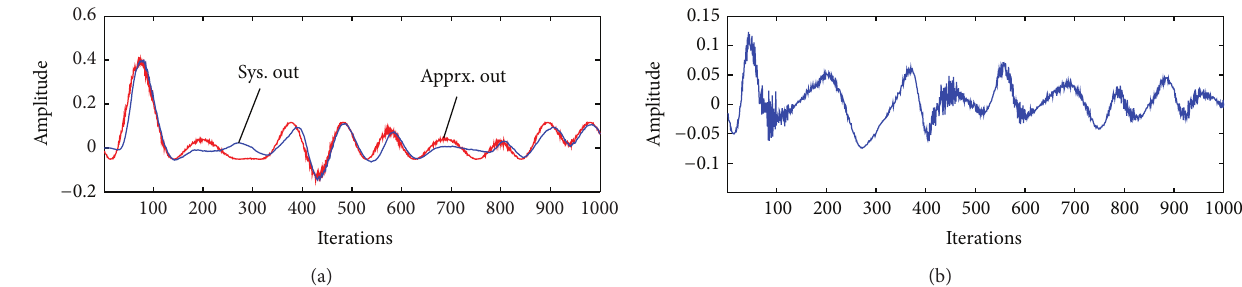
Figure 7: The simulation result with LMS algorithm. (a) Process of identification. (b) Error of identification.